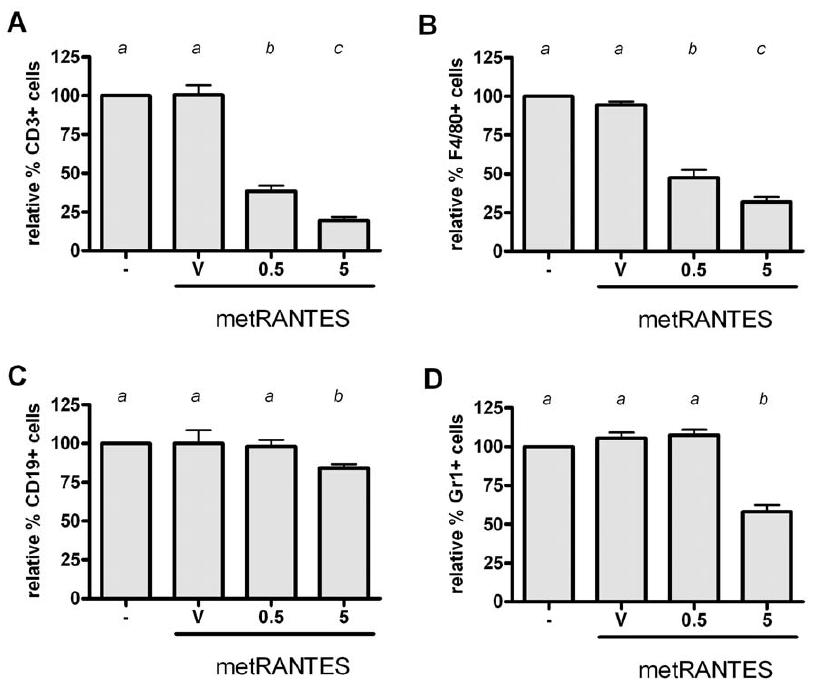
Figure 2. Phenotypic analysis of leukocytes migration interference by distinct doses of met-RANTES treatment. C57Bl/6 mice were infected orally with AA , treated with met-RANTES at 0.5 and 5 mg doses or (V) veicule and (-) non treated, sacrificed at day 30 post-infection and evaluated for relative number of: A) F4/80 + ; B) CD3 + ; C) Gr1 + ; and D) CD19 + cells in periodontal tissues of WT non-treated versus vehicle, 0.5 mg and 5 mg met-RANTES treated mice by flow cytometry, all performed as described in Material and methods. Results demonstrate the relative number of cells in % when compared with untreated group. Different italic low case letters represent statistically significant differences among the doses in the same experimental group (P , 0.05; One-way ANOVA), statistical analysis performed with raw data before % conversion.